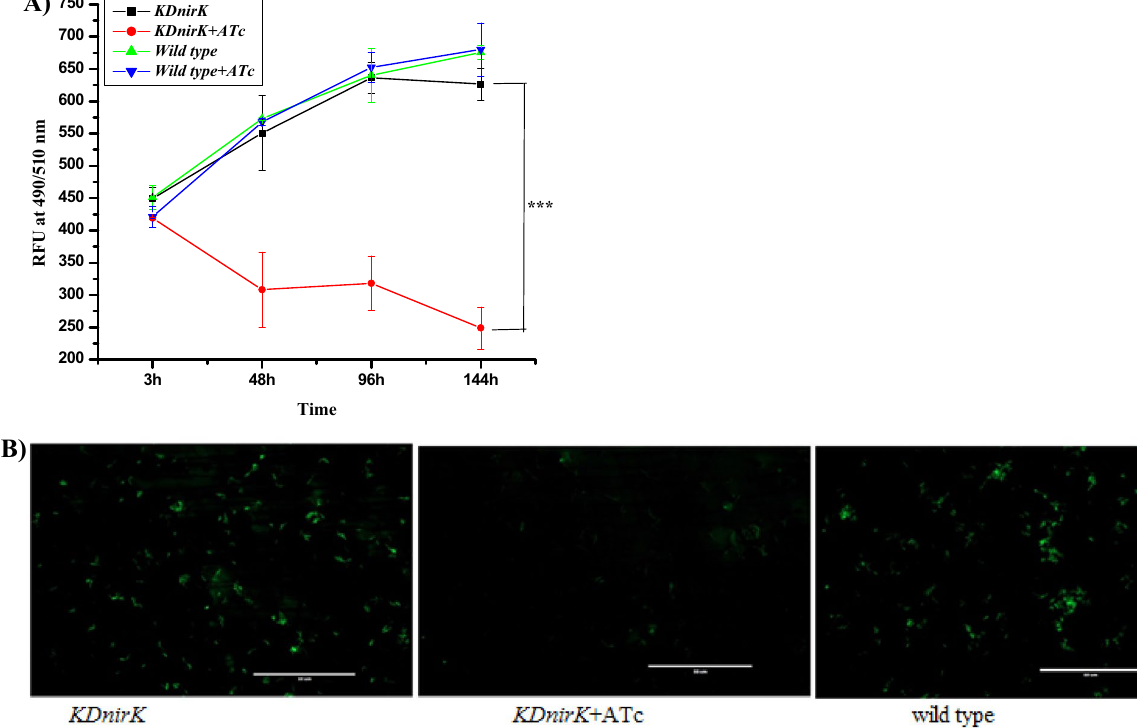
Figure 7. NO synthesis in nirK knock down clone of Mycobacterium tuberculosis : ( A ) Relative fluorescence units measured at 490/510 nm and ( B ) Fluorescence microscopy images captured of the KDnirK strain of Mtb bacilli in presence or absence ATc along with wild type control (Scale bar 50 μm) as mention in Materials and Methods section. The data is representative of triplicate experiments ±